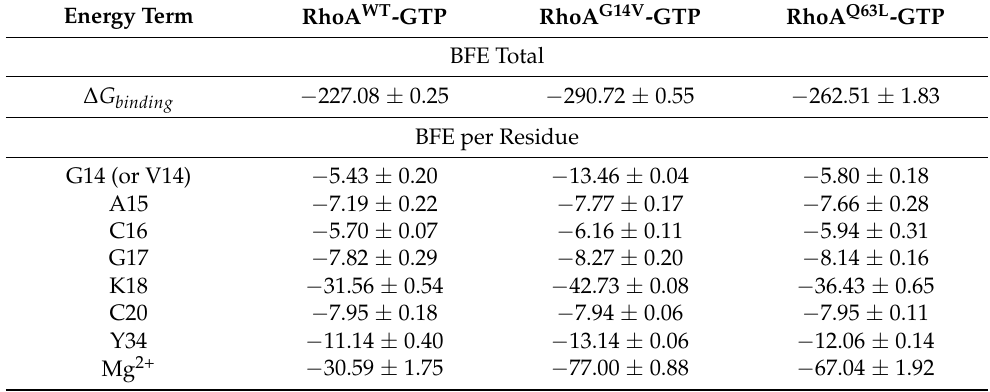
Table 1. Binding free energy (BFE) of GTP complexed with RhoA WT , RhoA G14V , and RhoA Q63L †